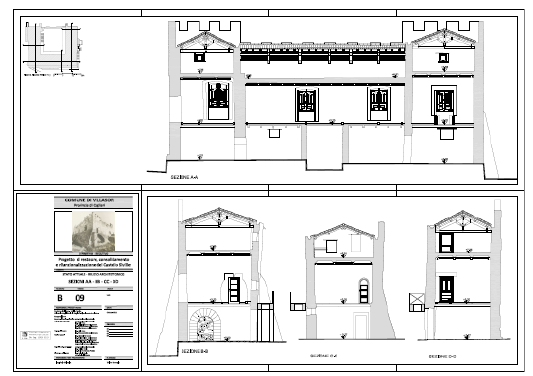
Fig. 11:Vertical